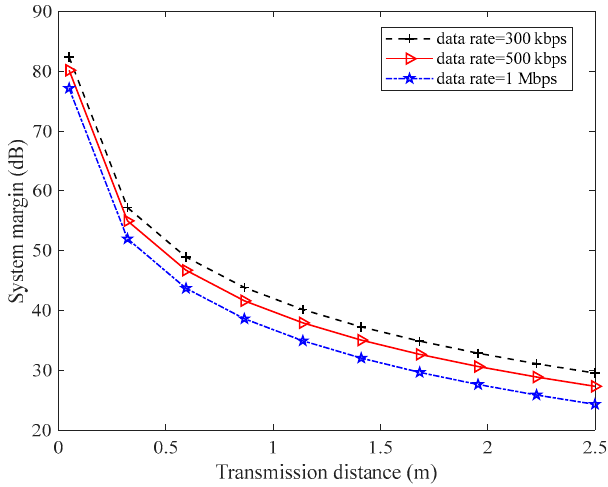
Figure 3. Link quality versus transmission distance under different rates.